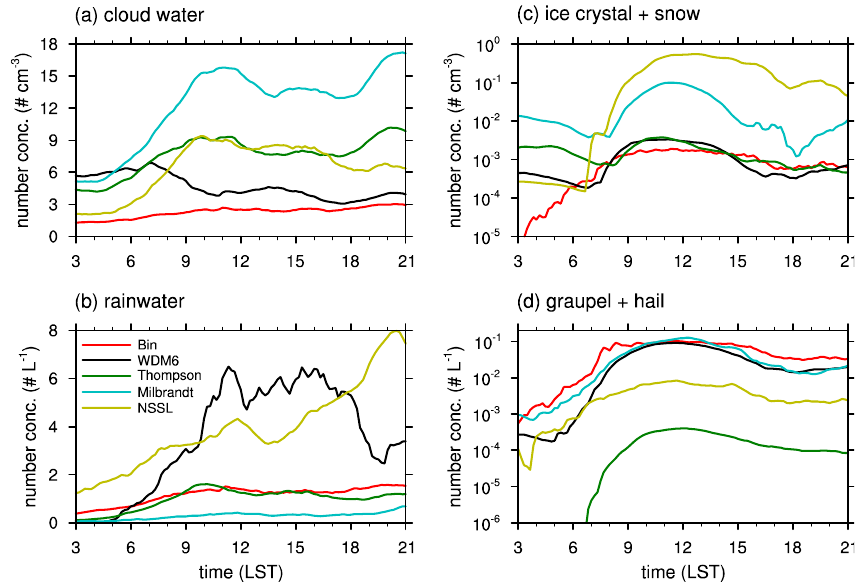
Figure 8. Time series of domain-averaged number concentrations of ( a ) cloud water, ( b ) rainwater, ( c ) pristine and aggregated ice particles (ice crystal and snow), and ( d ) rimed ice particles (graupel and hail). Note that each panel has its own unit and scale.